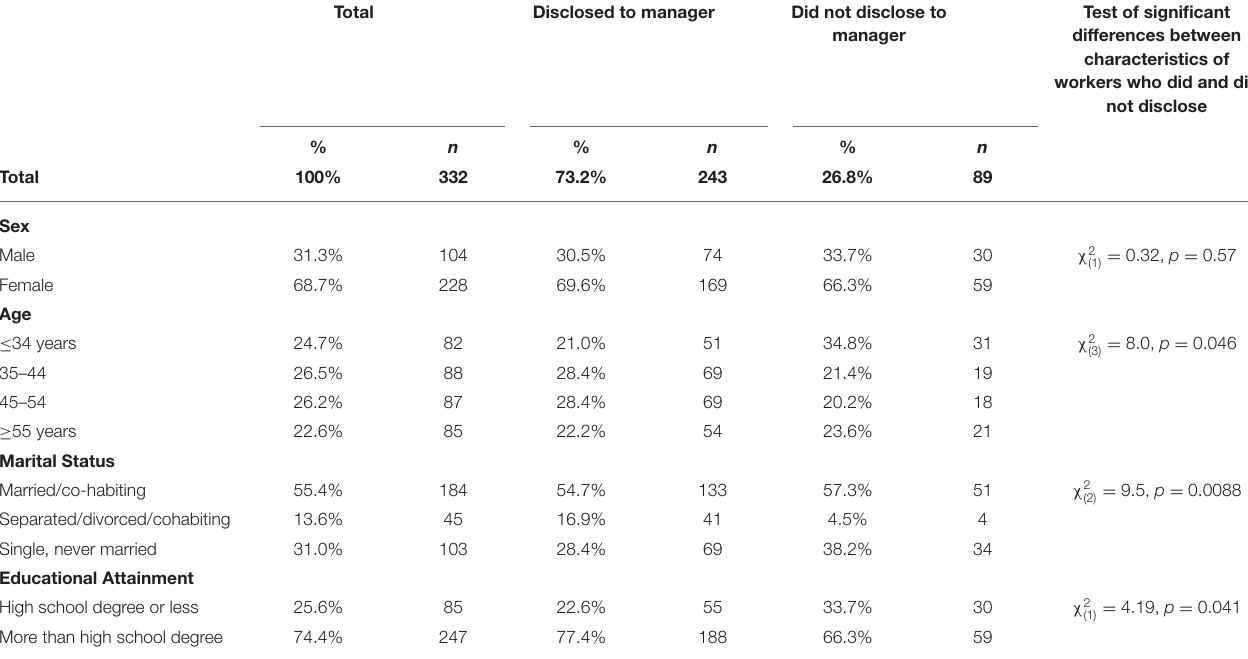
TABLE 1 | Demographic characteristics by disclosure to